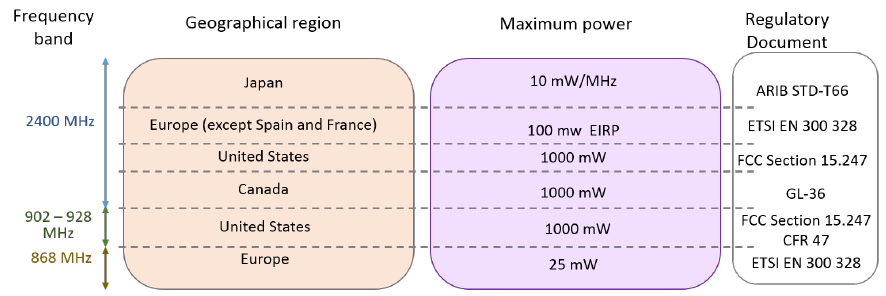
Figure 10. IEEE 802.15.4 maximum transmission power levels according to regions.